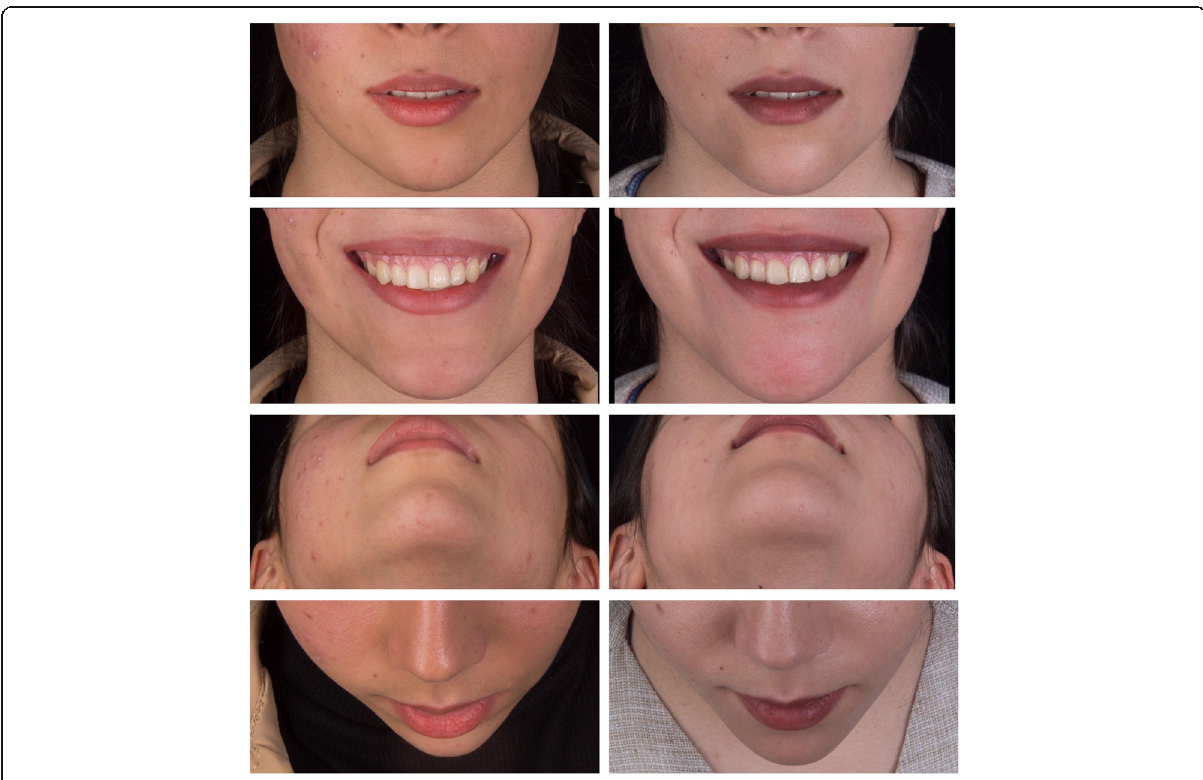
Fig. 4 Pre-operative (left) and post-operative (right) views of a sample patient who underwent computer-assisted horizontal translational osseous